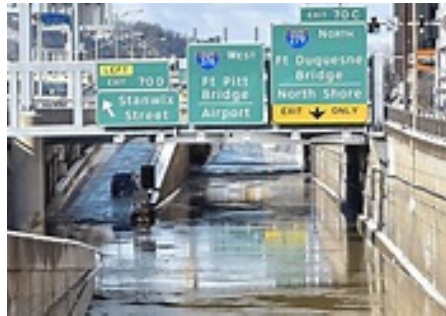
Figure 2. Pittsburgh, PA.